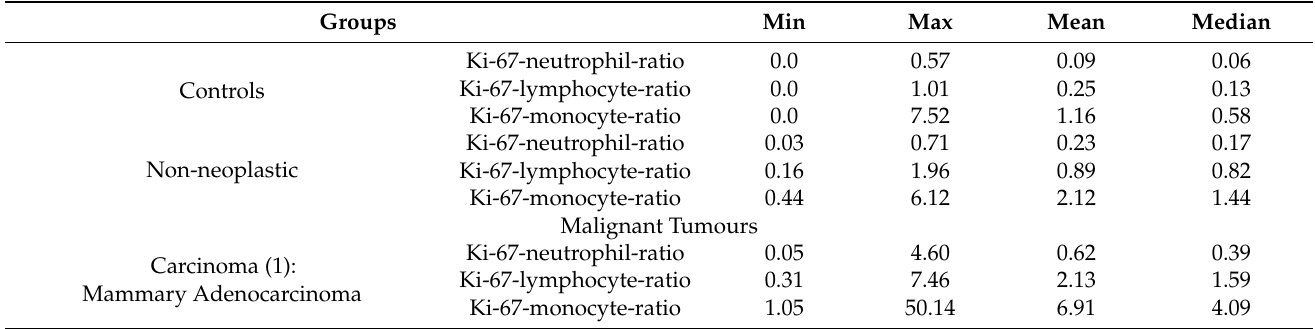
Figure 6. Comparison of different inflammatory parameters of healthy dogs, dogs with non-neoplastic diseases, and the different malignant tumour groups. ( A ) The neutrophil counts of the non-neoplastic diseased dogs were significantly higher than those of the healthy and the malignant tumour group ( p = 0.031 and p = 0.023, respectively). The neutrophil counts between the healthy and the malignant tumour group did not differ significantly ( p = 0.59). ( B ) The group of non-neoplastic diseased dogs had significantly higher lymphocyte counts than the malignant tumour group ( p = 0.011). No significant difference between the lymphocyte counts of the healthy and the non-neoplastic diseased dogs and between the healthy and the malignant tumour group was found ( p = 0.77 and p = 0.056, respectively). ( C ) The monocyte counts of the non-neoplastic diseased dogs were significantly higher than those of the healthy and the malignant tumour group ( p = 0.006 and p = 0.011, respectively). The monocyte counts between the healthy and the malignant tumour group did not differ significantly ( p = 0.34). ns, not significant. (*) p < 0.05; (**) p < 0.01. Similarly, establishing ratios between serum Ki-67 concentrations and neutrophil, lym- phocyte, and monocyte counts as indicators of inflammation, as well as components of the tumour microenvironment, was unable to distinguish mammary adenocarcinomas from adenomas ( p = 0.83, p = 0.50 and p = 0.45, respectively; Table 5). However, comparing ratios of serum Ki-67 concentrations and neutrophils, lymphocytes, or monocytes of the sarcoma group with the non-neoplastic diseased group, a statistically significant difference was found in all three cases, with the diseased group showing lower values than the sarcoma group ( p = 0.04, p = 0.03 and p = 0.02, respectively; Table 5; Figure 7A–C). This obser- vation cannot be reproduced when comparing ratios of serum Ki-67 concentrations and neutrophils, lymphocytes, or monocytes of the lymphoma group with the non-neoplastic diseased group ( p = 0.076, p = 0.104 and p = 0.16, respectively; Table 5; Figure 8A–C). Table 5. Ratios of Ki-67 and neutrophil, lymphocyte and monocyte counts of all dogs examined in this